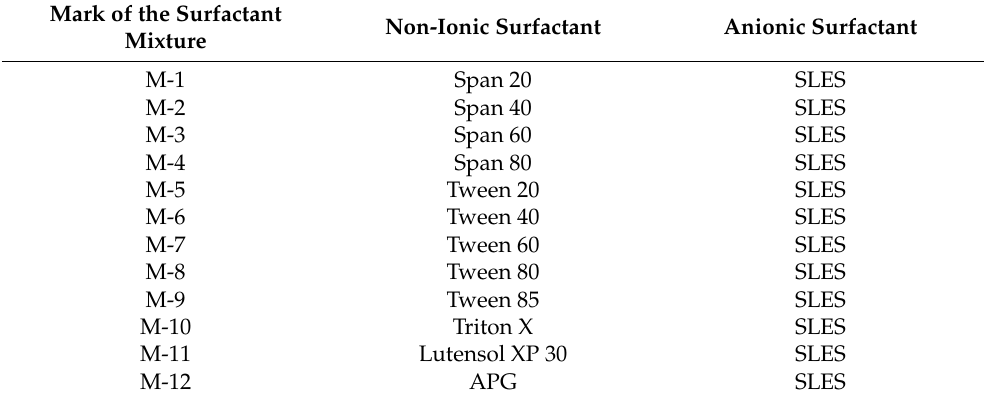
Table 2. Components of surfactant